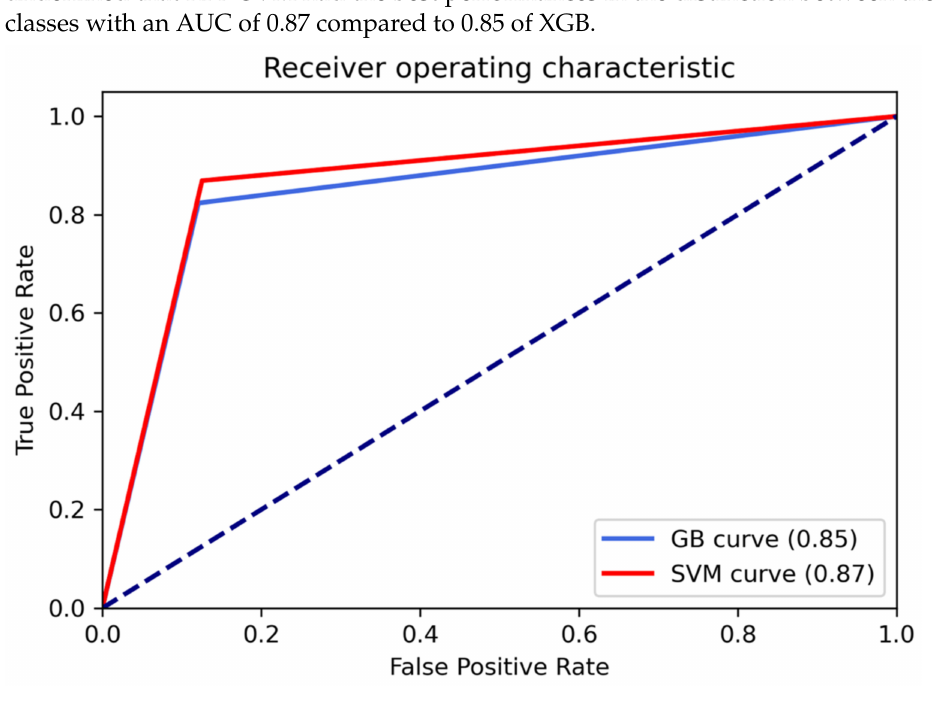
Figure 3. Receiver operating characteristic curve for SVM and